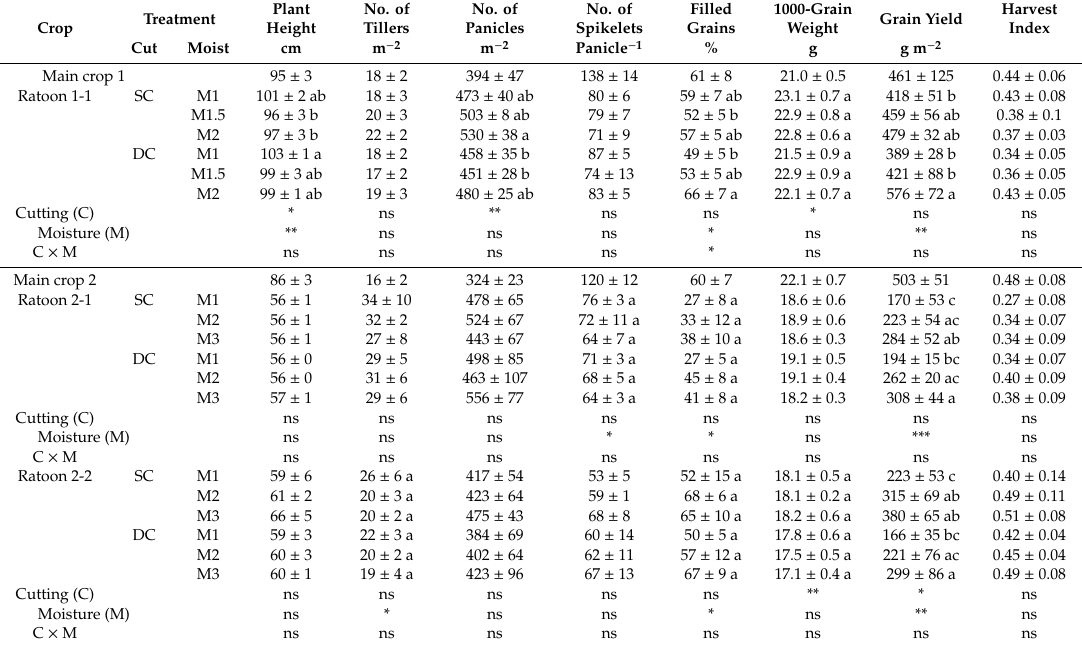
Table A1. Mean comparison for the plant height, no. tiller, yield components and yield, and harvest index of each